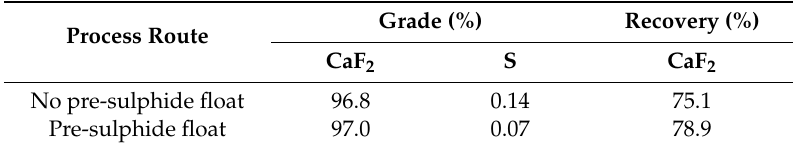
Table 4. Comparison of the metallurgical performance different process routes in terms of pyrite removal using lignin sulphonate depressant at 170 g / t dosage for ore